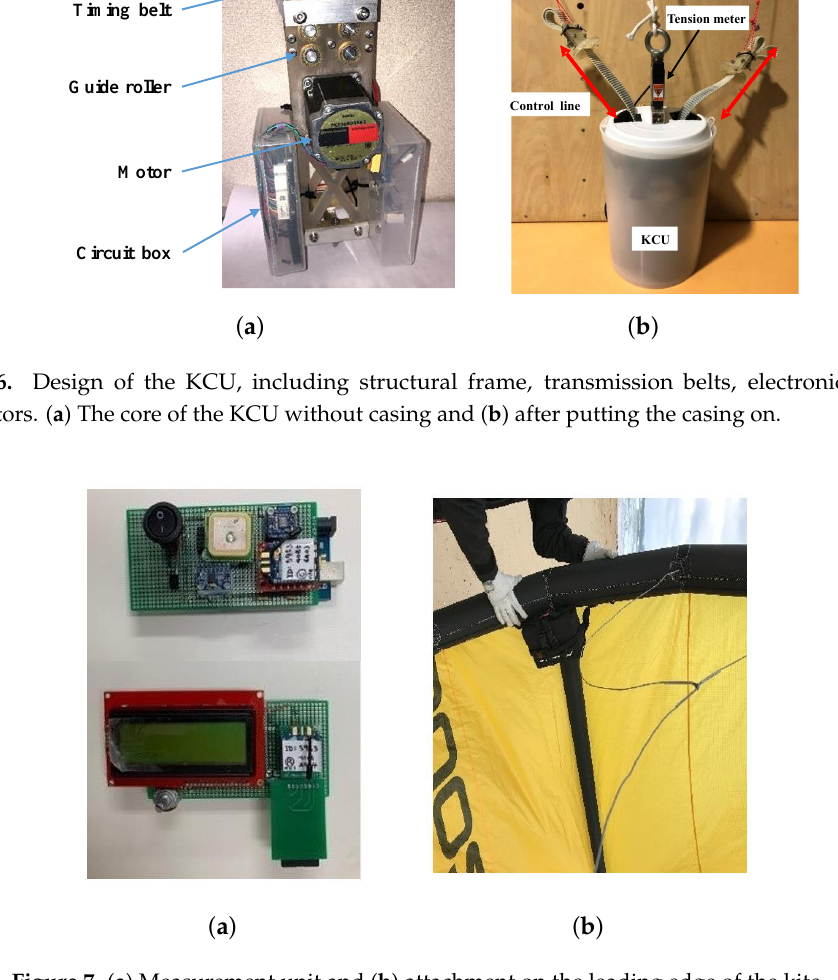
Figure 7. ( a ) Measurement unit and ( b ) attachment on the leading edge of the kite.